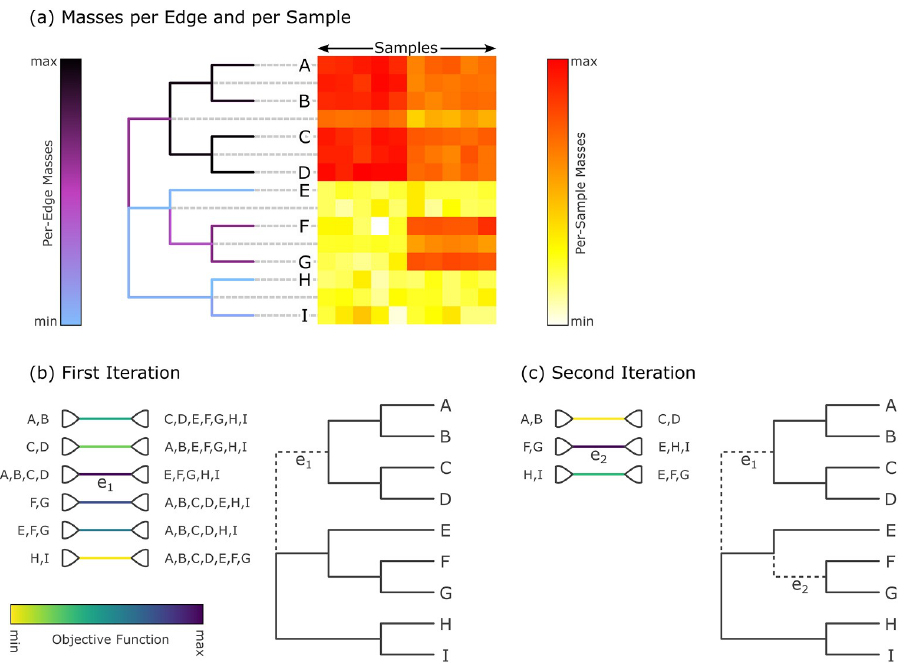
Fig 7. Input data and first two iterations of Placement-Factorization. The figure resembles Figure 2 of [31]. It shows the adaptation of concepts from Phylofactorization to phylogenetic placement data. (a) The input data is a set of samples with placement masses on each edge of the tree. The tree is colorized by the total mass across all samples, that is, by the row sums of the heat map. The heat map then shows the detailed mass per edge (rows) and per sample (columns). Note that the heat map also contains rows for each inner edge of the tree, as phylogenetic placement also considers these edges. We show an example of this visualization for empirical data in S1 Fig. (b) In the first iteration, the objective function for all inner edges is evaluated. Here, e 1 is the winning edge that maximizes the objective function, which separates ( A , B , C , D ) from the rest of the tree. (c) In the second iteration, only the contrasts within the two subtrees are calculated, but not across the winning edges of previous iterations (here, e 1 ). That is, the winning edge e 2 maximizes the objective function that contrasts ( F , G ) with ( E , H , I ), but does not consider the edges in the subtree ( A , B , C , D ). Note that in our adaption, edges that lead to a tree tip are not considered as potential